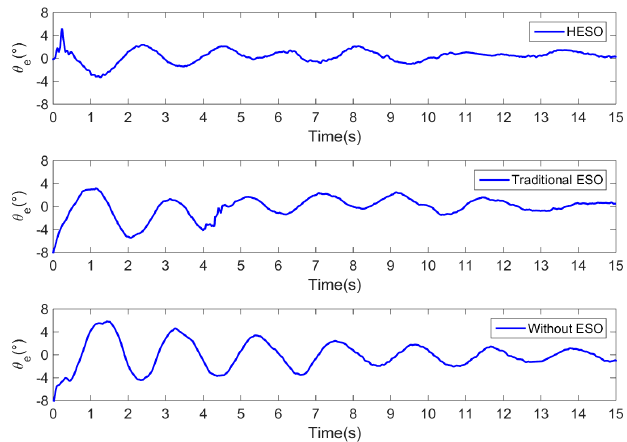
Figure 10. Experimental curves of θ with different ESO. Electronics 2018 , 7 , x FOR PEER REVIEW